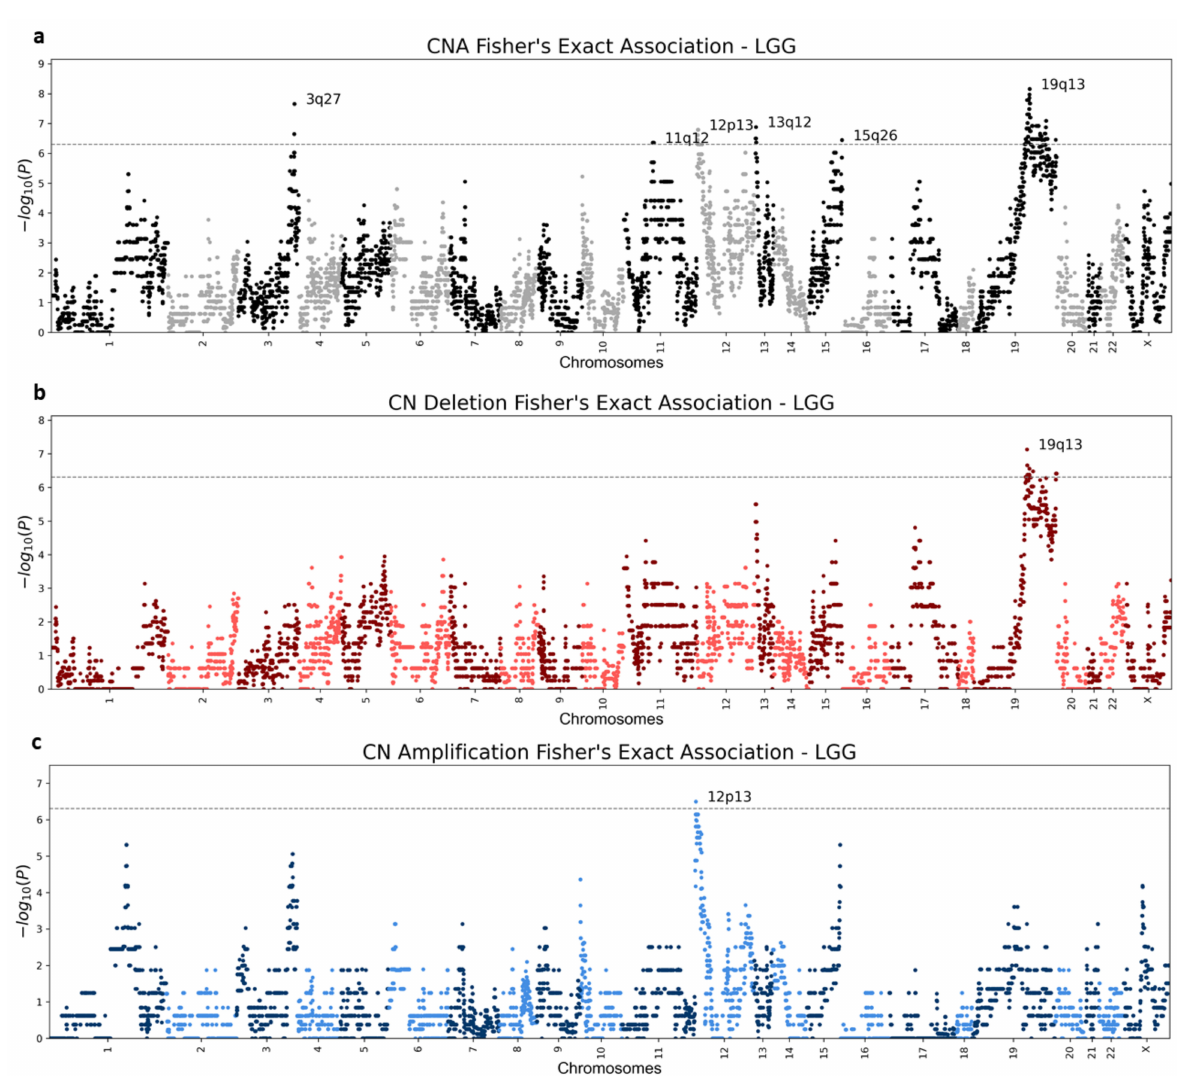
Figure 5. LGG (Brain lower grade glioma) Manhattan plots. Genic Manhattan plot over Fisher’s exact test p -values between LGG chromoanagenesis samples and non-chromoanagenesis samples. ( a ) LGG Manhattan CNA (combined deletion or amplification) plot. ( b ) LGG Manhattan plot of deletion events. ( c ) LGG Manhattan plot for amplification events. The sequential chromosomes are colored differently for visualization purposes. The conservative significance statistical threshold is set to 5 × 10 − 7